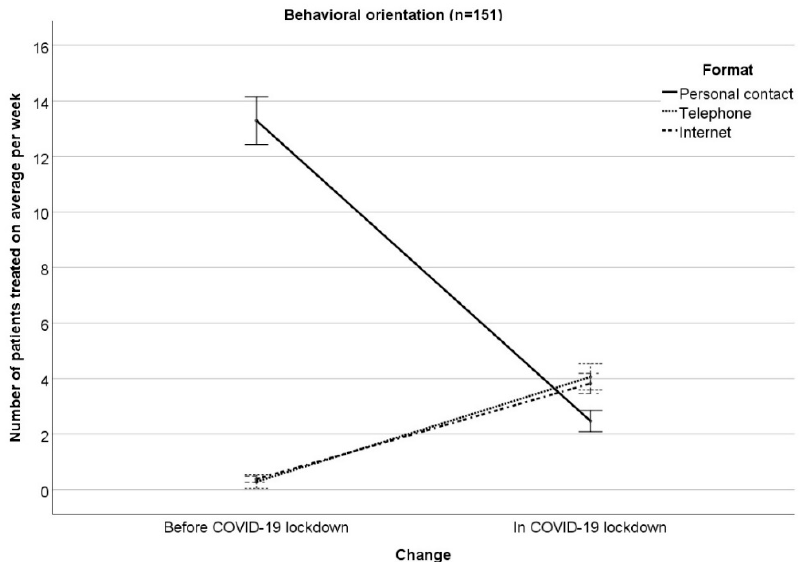
Figure 3. Number of patients treated on average per week in personal contact, via telephone, via Internet in the months before/in COVID-19 lockdown for systemic orientation. Mean ± 1 standard error.